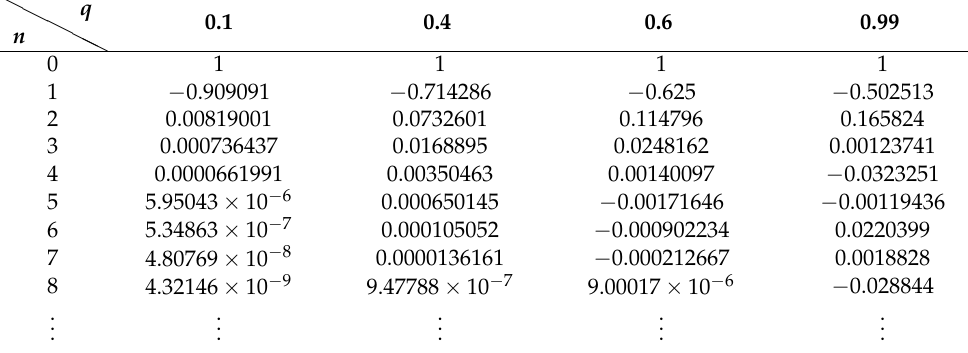
Table 1. Approximate values of B n , q .